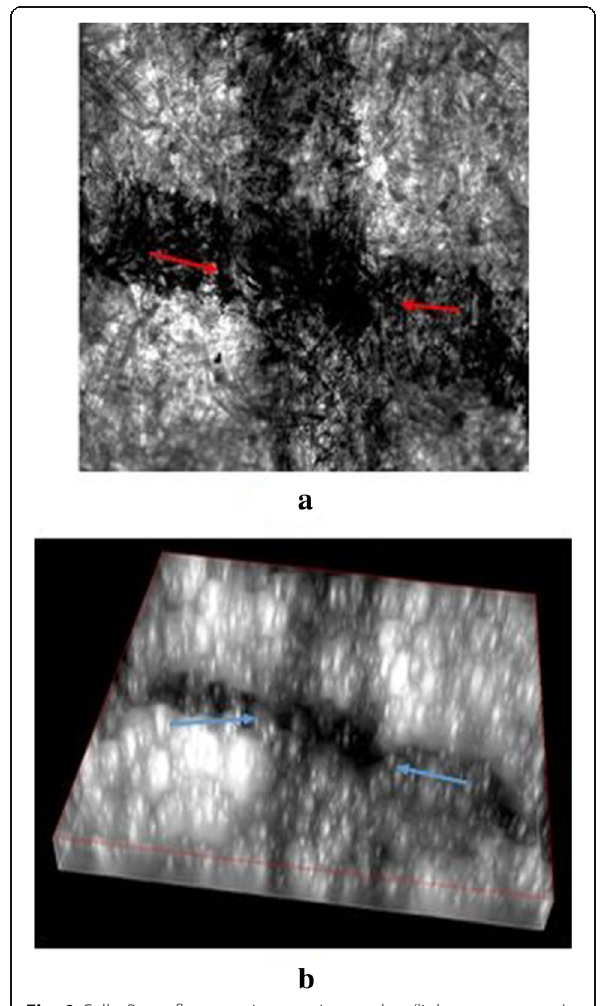
Fig. 9 Cello Butterflow pen intersecting strokes (light pen pressure). a 2D figure. b 3D figure